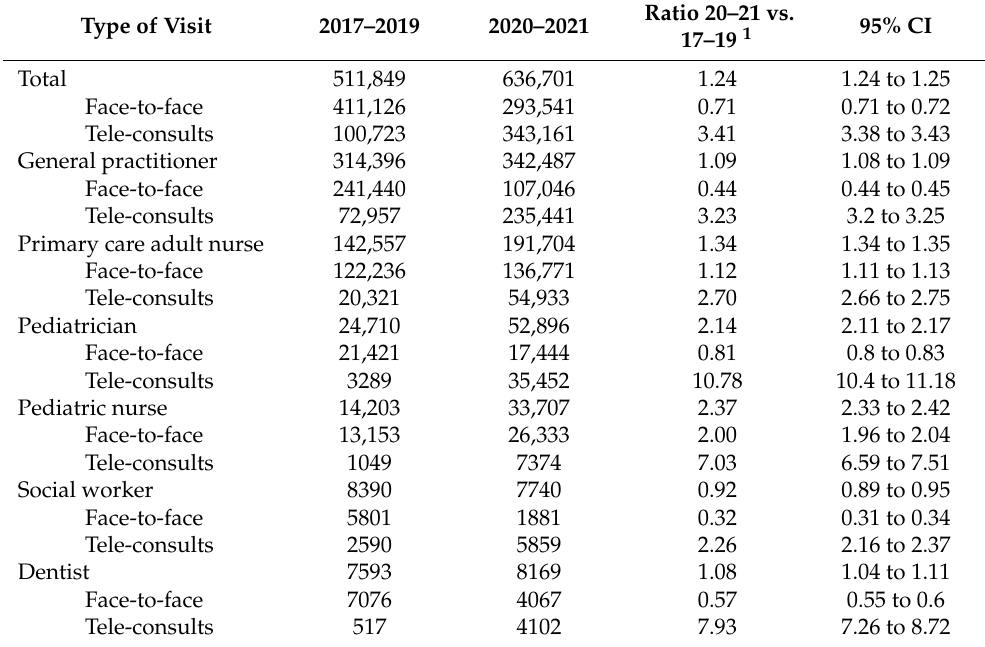
Table 1. Mean visits to PHC professionals during the pre-pandemic period and the two years of COVID-19. Visit ratios for number of mean visits in 2020 and 2021 compared with mean visits from 2017 to